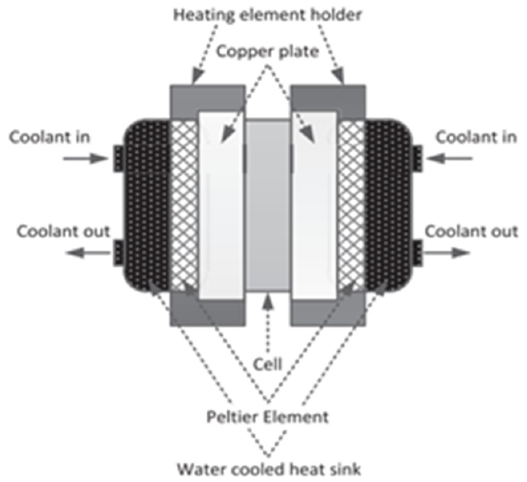
Figure 11. Schematic diagram of Parr element [74]. Reproduced from reference [74] with permission from Elsevier B.V., copyright 2014.